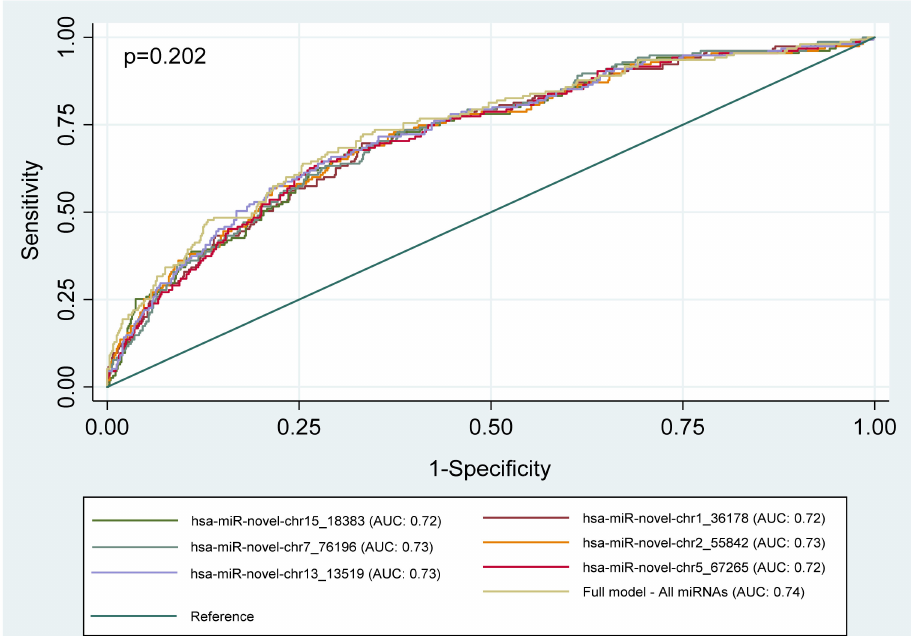
Figure 2. Area under the receiver operating characteristics (ROC) curves (AUC), illustrating the diagnostic ability of six novel whole blood miRNAs to discriminate between individuals with CKD and those without in a group of high-risk individuals. Models: miRNA + age + gender + smoking status + drinking status + DM status + HTN status. Full model includes all six miRNAs. Abbreviation: miRNA